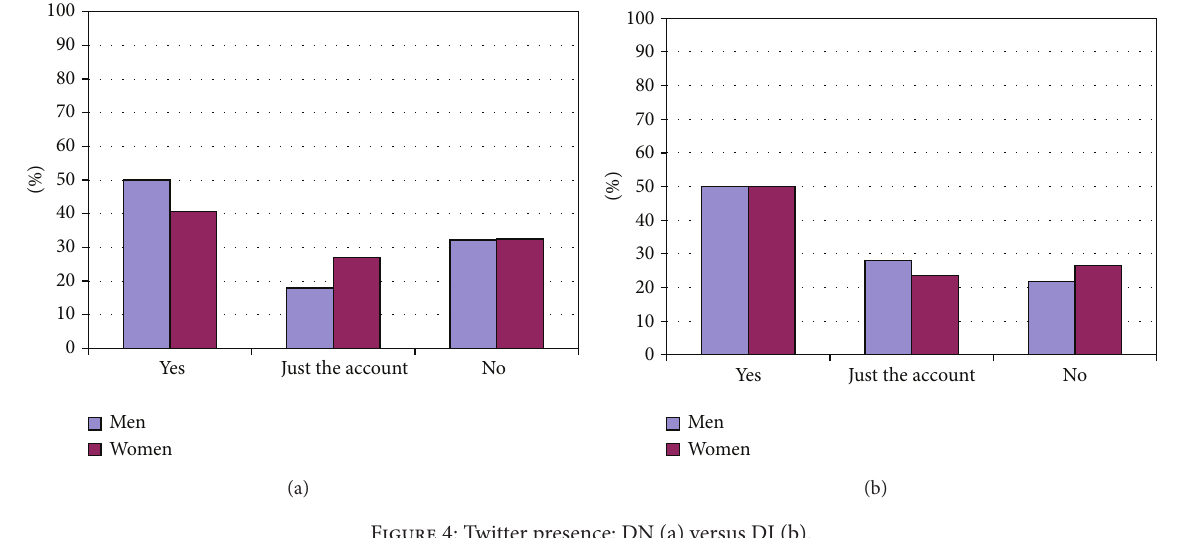
Figure 4: Twitter presence: DN (a) versus DI